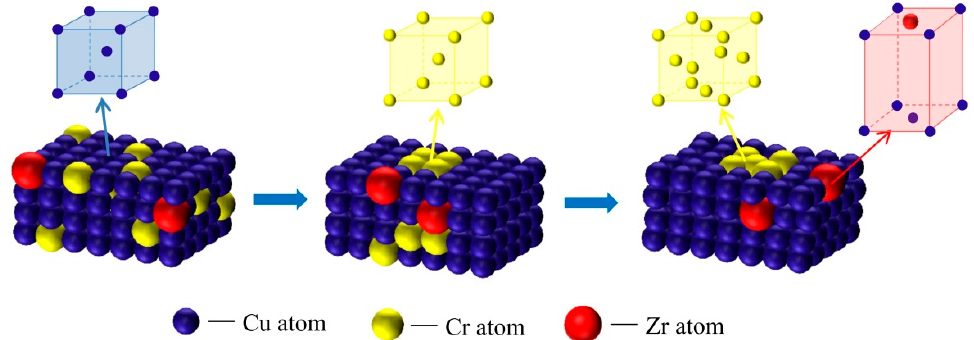
Figure 6. Schematic diagram of the phase precipitation.